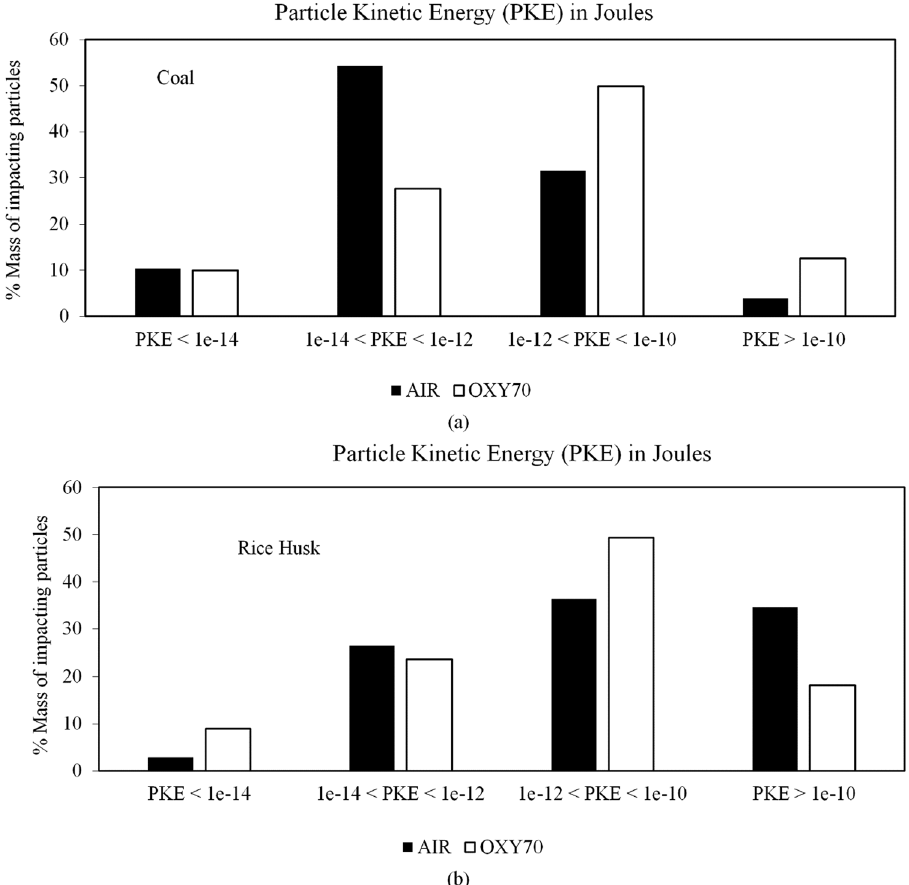
Fig. 7 Histograms representing the kinetic energy distribution of the impacting particles a Coal ash b RH